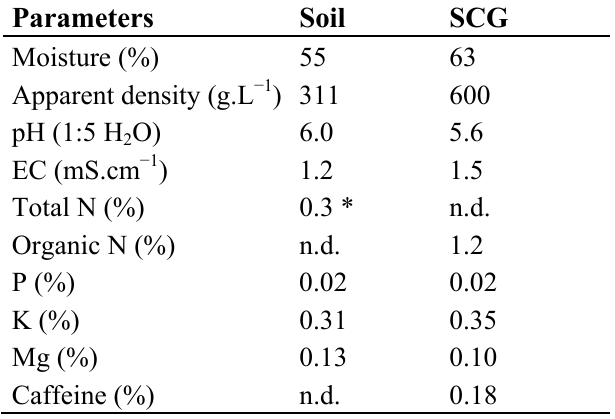
Table 3. Physicochemical characterization of vegetable soil and SCG used for